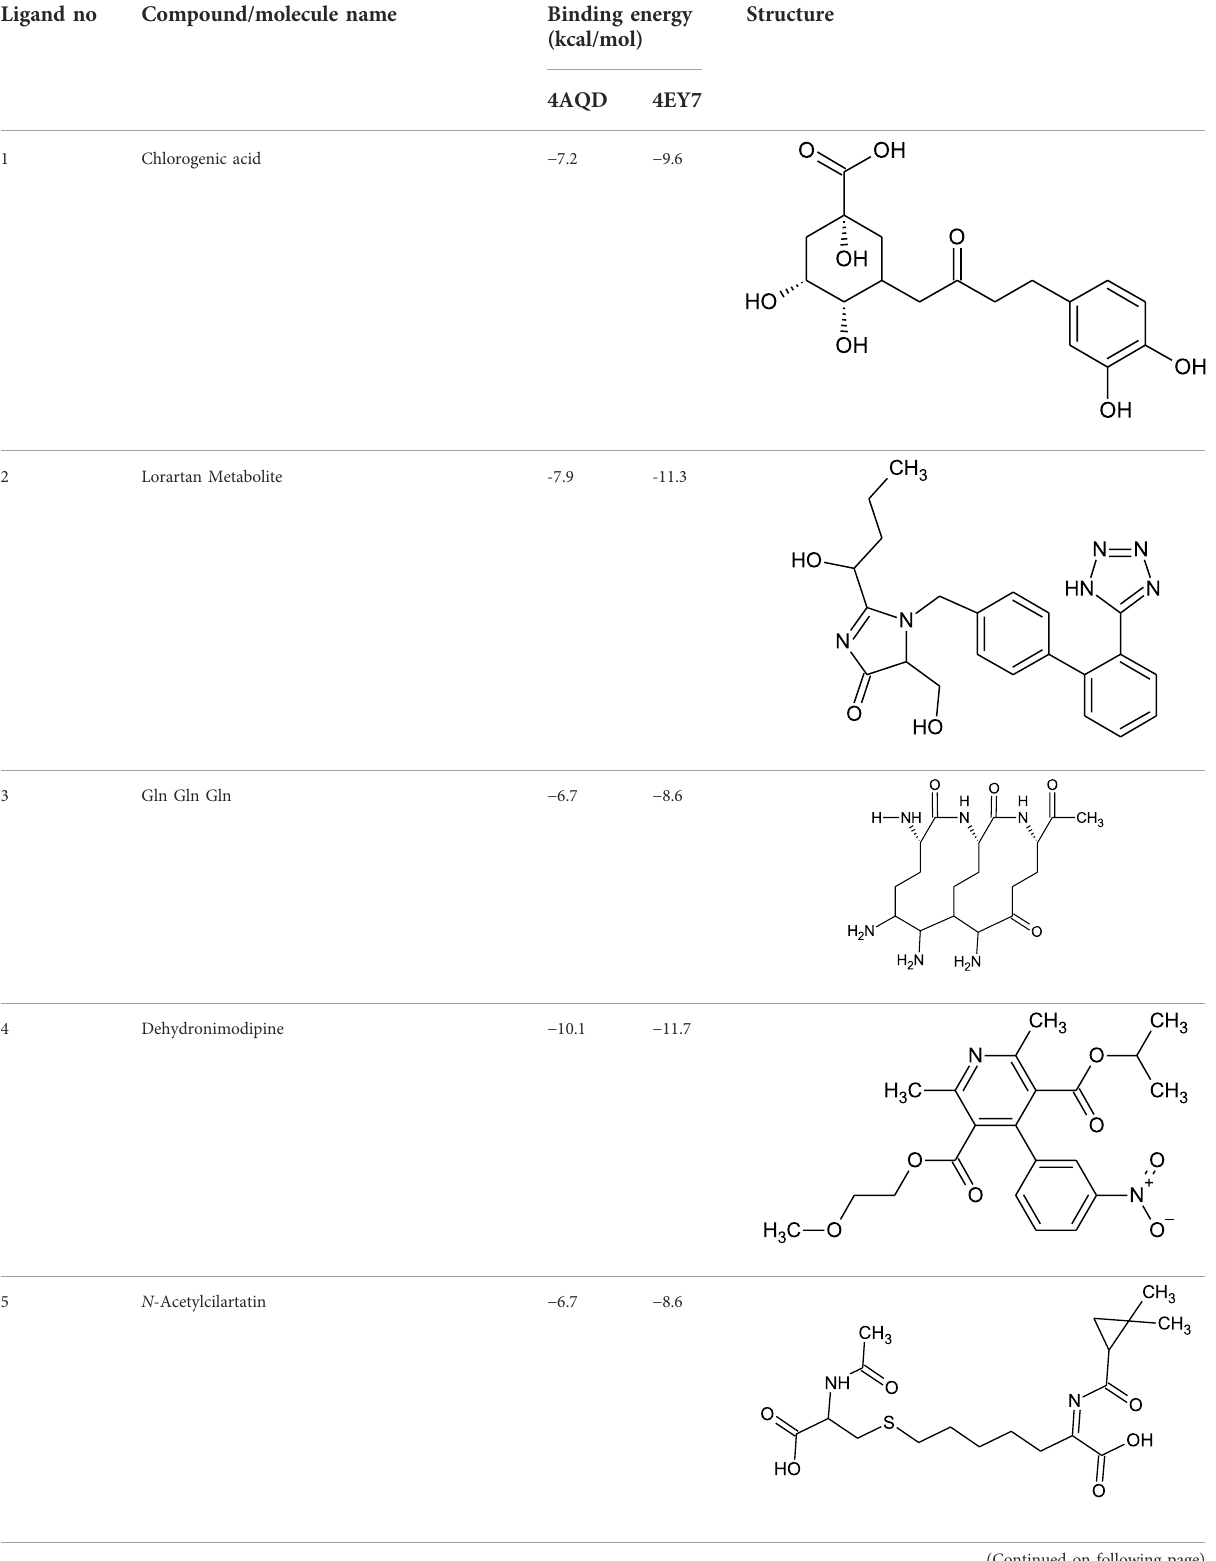
TABLE 1 Representing the 2D images of all the 25 ligands and their binding energy details against 4AQD and 4EY7